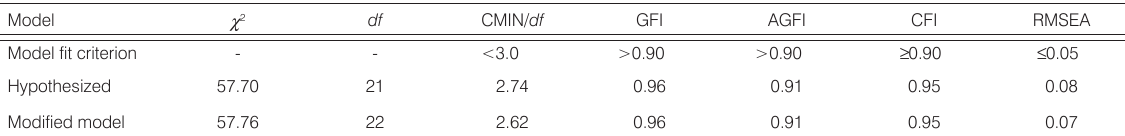
Table 3. Model fitness indices between the hypothesized model and the modified model ( n = 272)